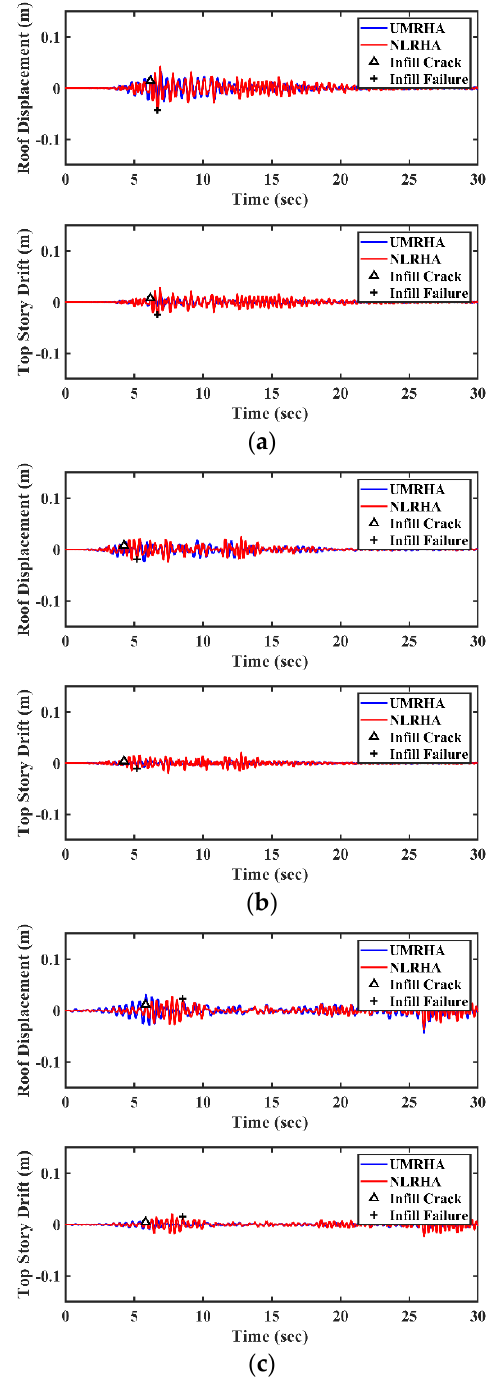
Figure 19. Comparison of roof displacement and top-story drift of RES open top-story frame subjected to the selected ground motions: ( a ) Imperial Valley; ( b ) Kobe; ( c ) Landers.